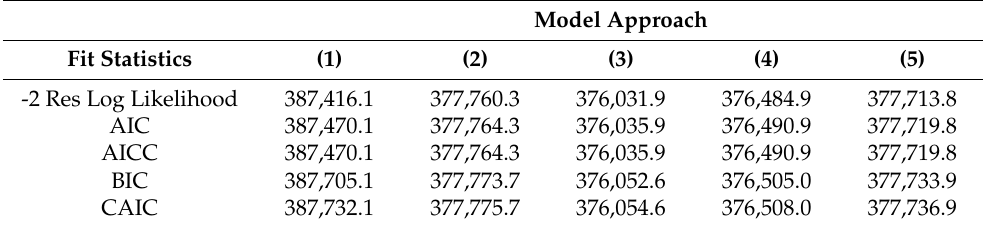
Table 4. Fit statistics (smaller is better) for different model approaches.